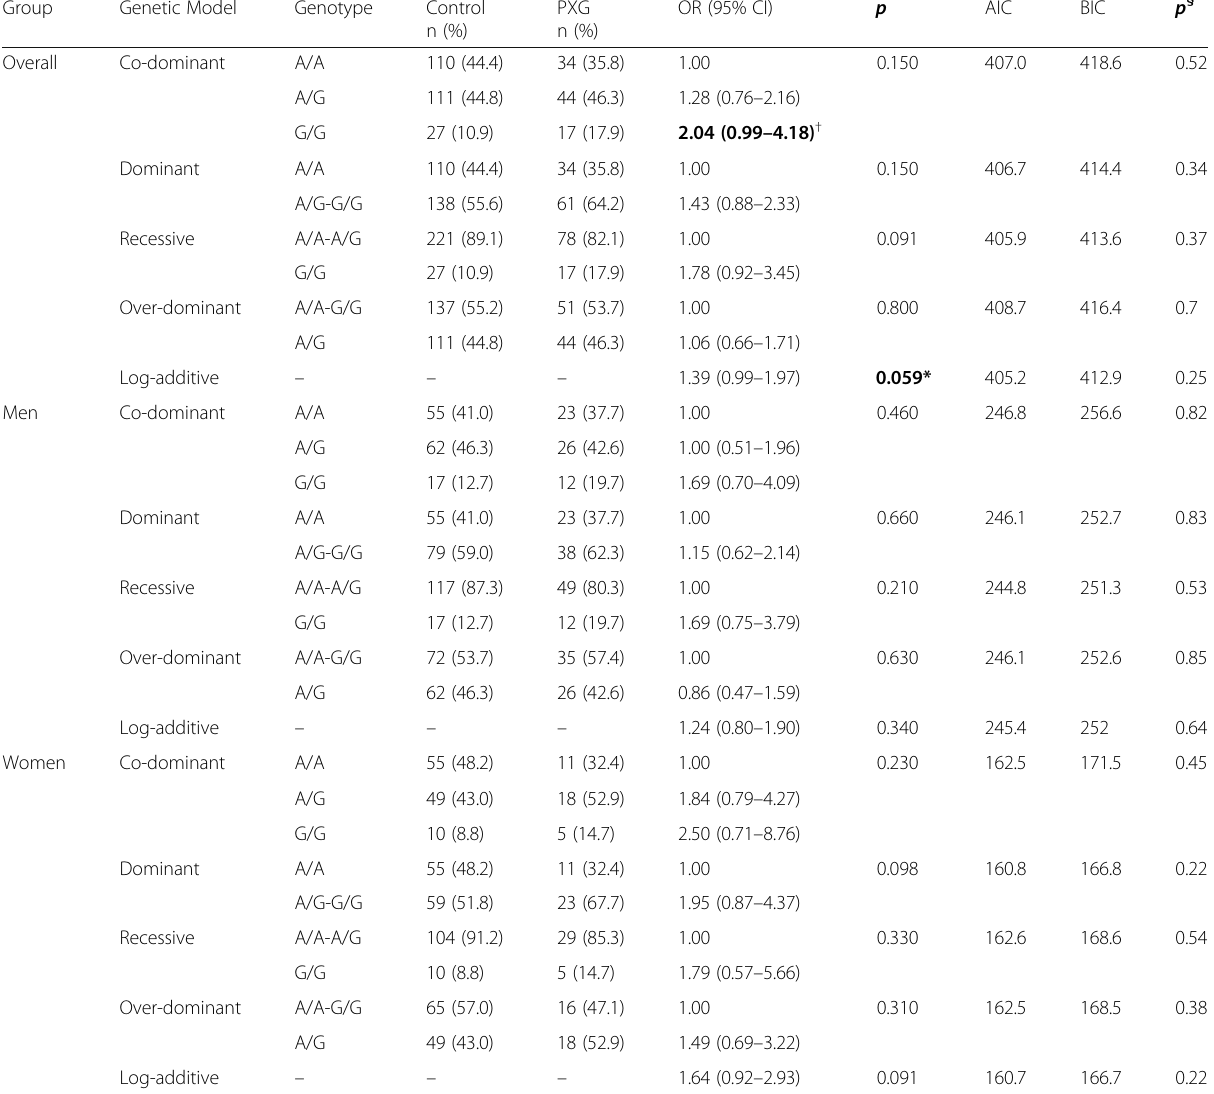
Table 4 Association analysis of rs12997 variant in ACVR1 with primary pseudoexfoliation glaucoma Group Genetic